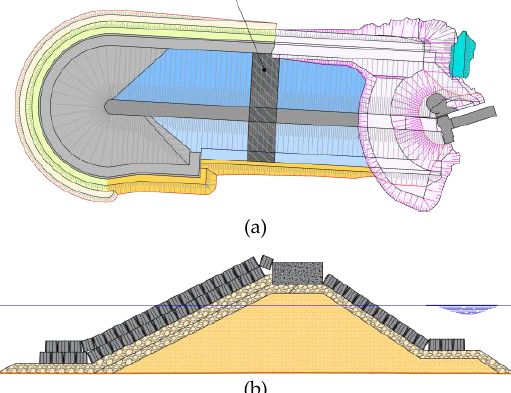
Fig. 1. Planned extension of the North breakwater of the Port of Leixões: (a) plan view and (b) cross section.